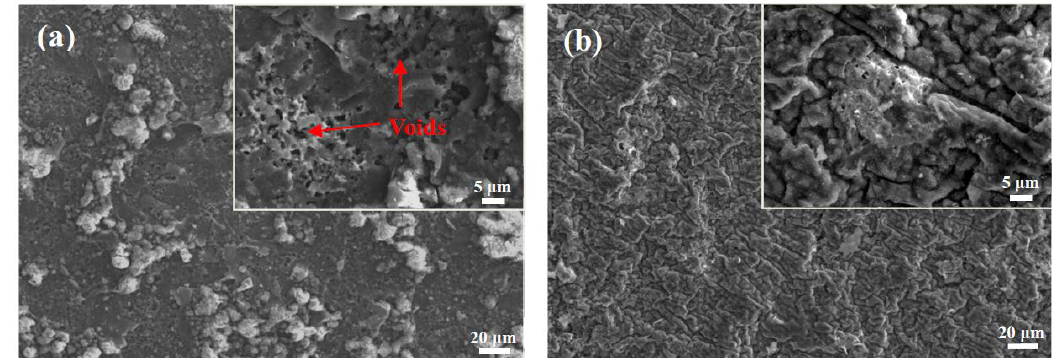
Figure 3. Surface morphologies of the aluminide coating on an IN738 superalloy in air and air plus water vapour after being oxidized at 1050 °C for 150 h: ( a ) in air + water vapour, and ( b ) in air.